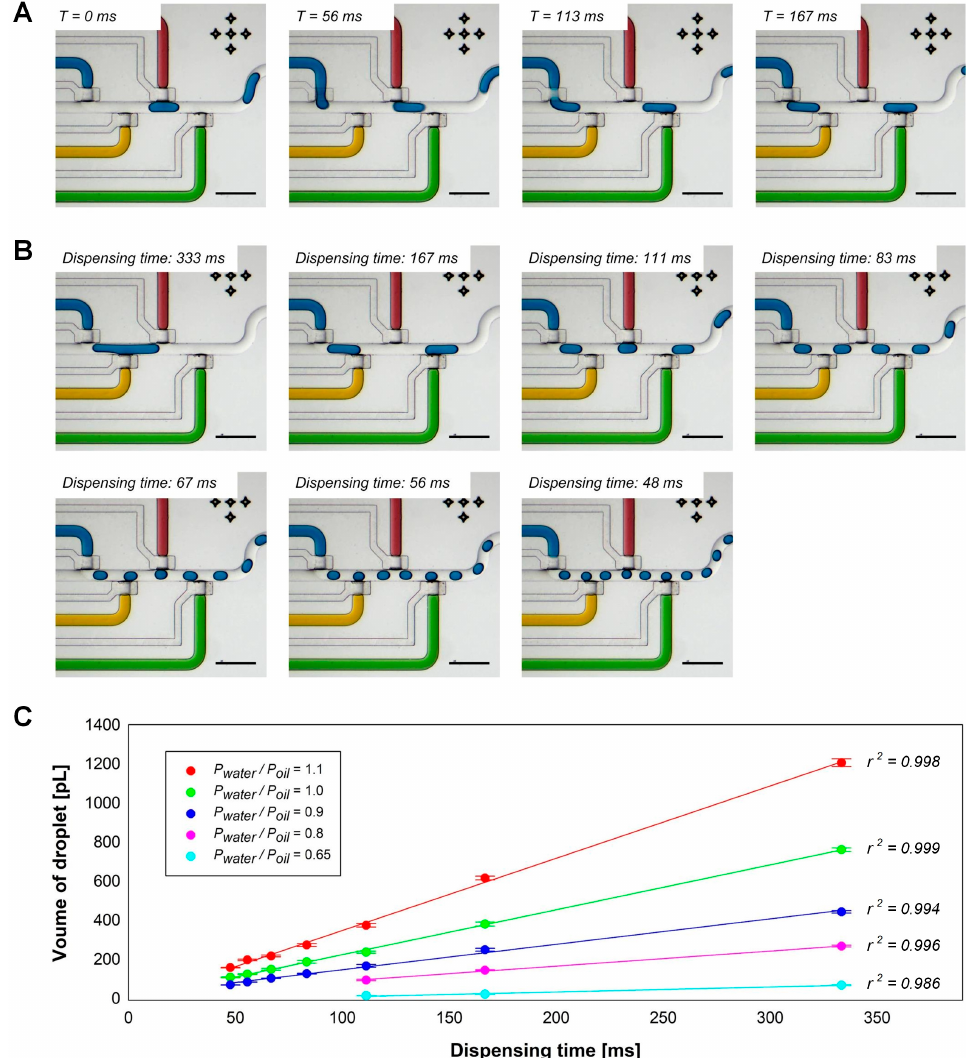
Figure 2. The w / o droplet generation with a pneumatically actuated microfluidic valve; ( A ) Step-by-step procedures of droplet formation at the constant droplet generation condition (P water / P oil = 1 and dispensing time = 167 ms); ( B ) Droplet size-control by varying the dispensing time at the constant fluid flow condition (Pwater / Poil = 1). Images captured from a recorded movie. Scale bars: 400 µ m; ( C ) relationship between the dispensing time and the volume of formed droplets at various fluid flow conditions (n = 20).